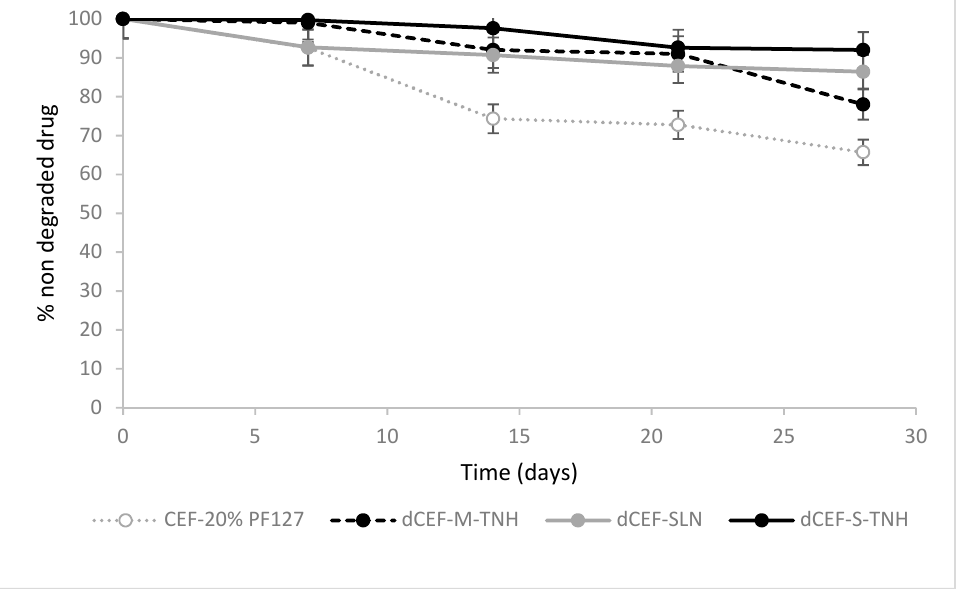
Figure 7. Long-term chemical stability upon storage at 4 °C of: CEF in 20% w/v PF127 hydrogel (dashed grey), dCEF-M-TNH (dashed black), dCEF-SLN (grey), dCEF-S-TNH (black). Each bar represents the mean ± SD ( n = 5). Significant differences versus CEF reference started from the 15th days for the dCEF-preparations ( p < 0.05), among the dCEF preparations no significative differences were noted during 28 days ( p > 0.05).